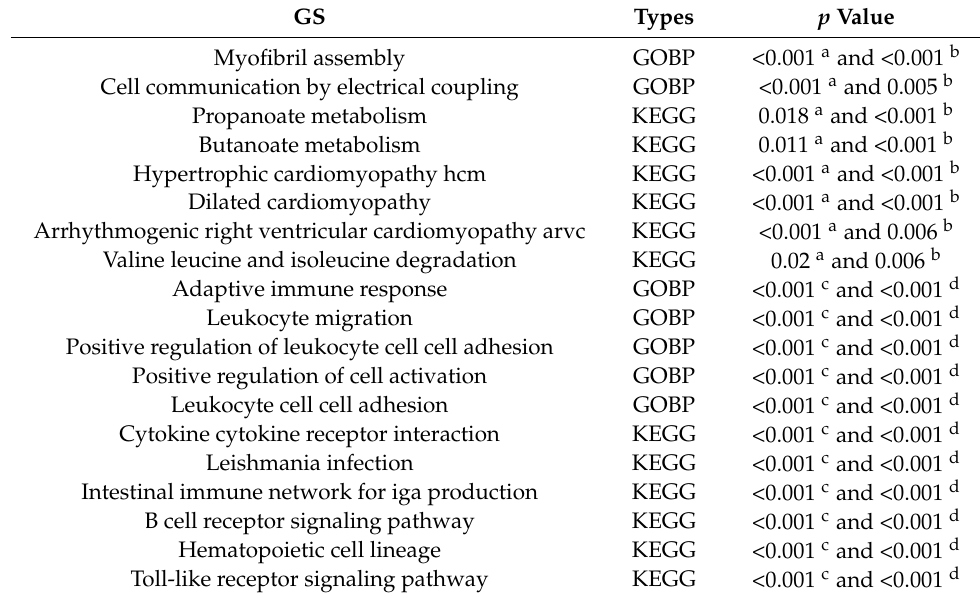
Figure 1. The summary of GSEA analysis based on GOBP and KEGG gene sets. ( A ) Venn diagram of gene sets enriched in non-plaque and early stage. ( B ) Venn diagram of gene sets enriched in plaque and advanced stage. The red color represents gene sets enriched in the non-plaque and plaque stages based on the dataset of GSE43292. The blue color represents gene sets enriched in the early stage and advanced stage based on the dataset of GSE28829. Table 1. The gene set enrichment analysis of gene expression omnibus database with accession numbers GSE43292 and GSE28829.